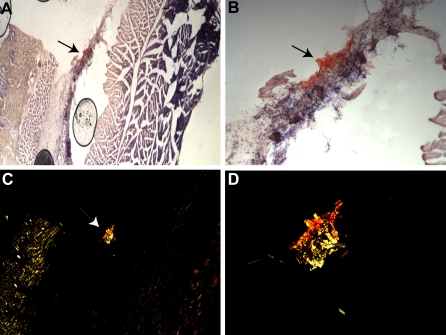
In Vivo Amyloid Formation of the GnRH Analog L14A total of 200 μg of L14 in 200 μl of 5% D-mannitol was injected subcutaneously into an adult rat, which was sacrificed 1 d later. Tissue sections close to the injection site were stained with CR. In (A) and (B), the red CR staining, and in (C) and (D), the CR birefringence is observed indicative of in vivo amyloid formation. The pictures of (A) and (B) represent the bright-field microscope images with 5× and 10× resolutions, respectively. The same section is shown in (C) and (D) under cross-polarized light with 5× and 10× magnification, respectively.